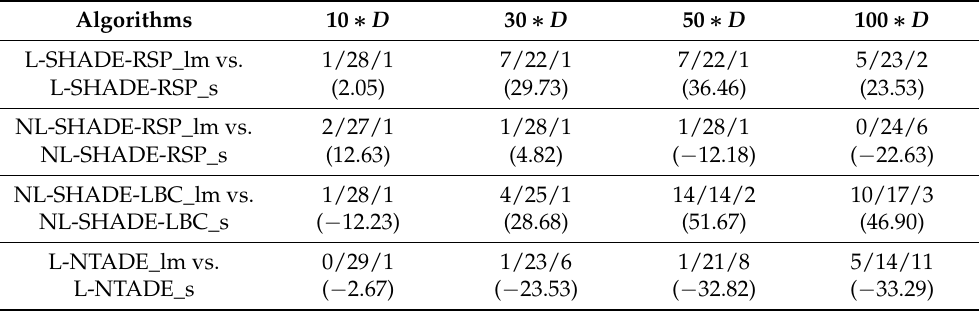
Table 5. Algorithms with crossover rate sorting and biased Lehmer mean, CEC 2017, Mann–Whitney tests and total standard score.